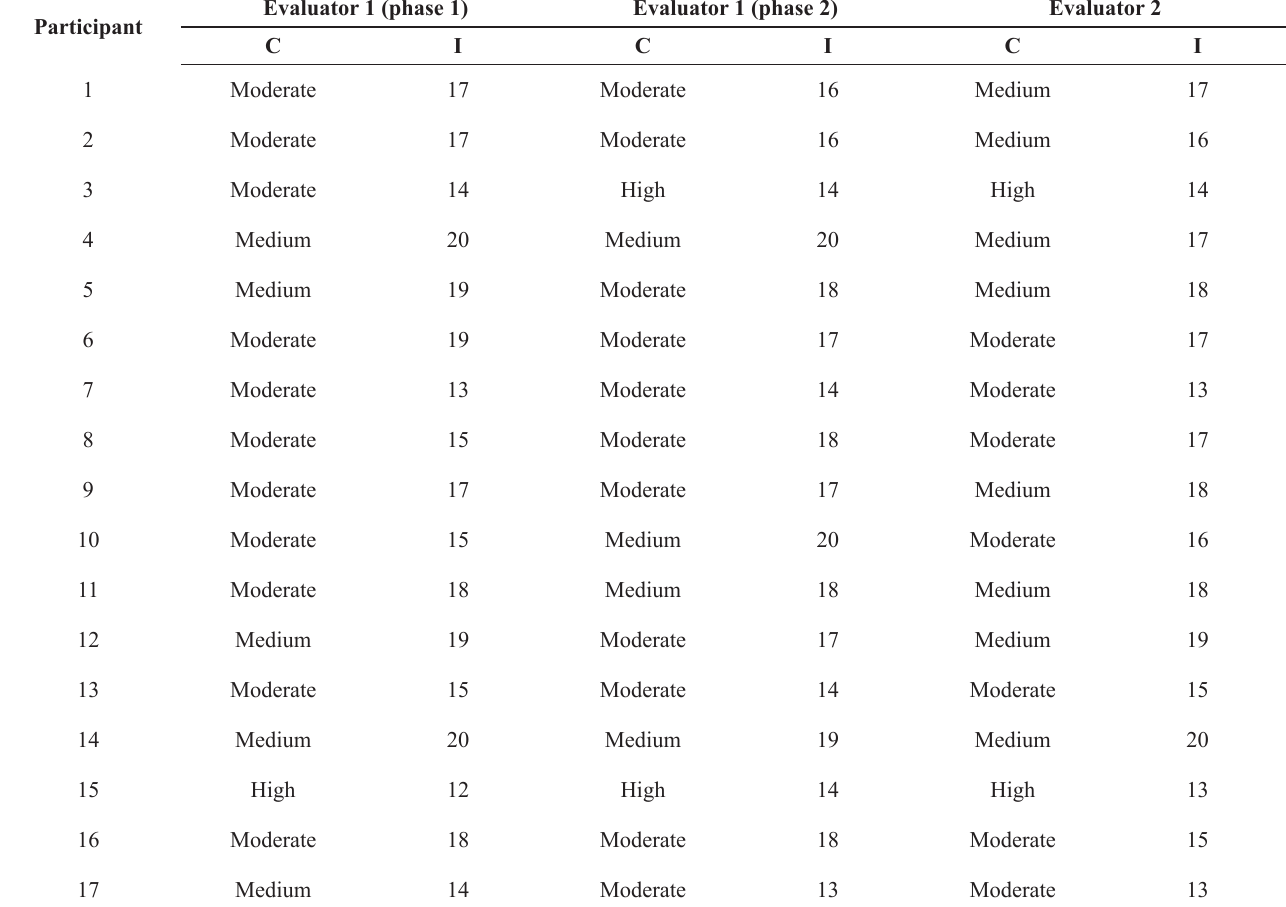
Table 3 - Total points and injury risk rating evaluation of the 17